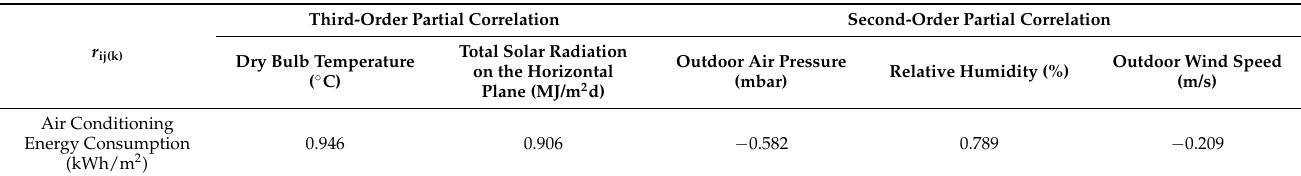
Table 9. Partial correlation analysis